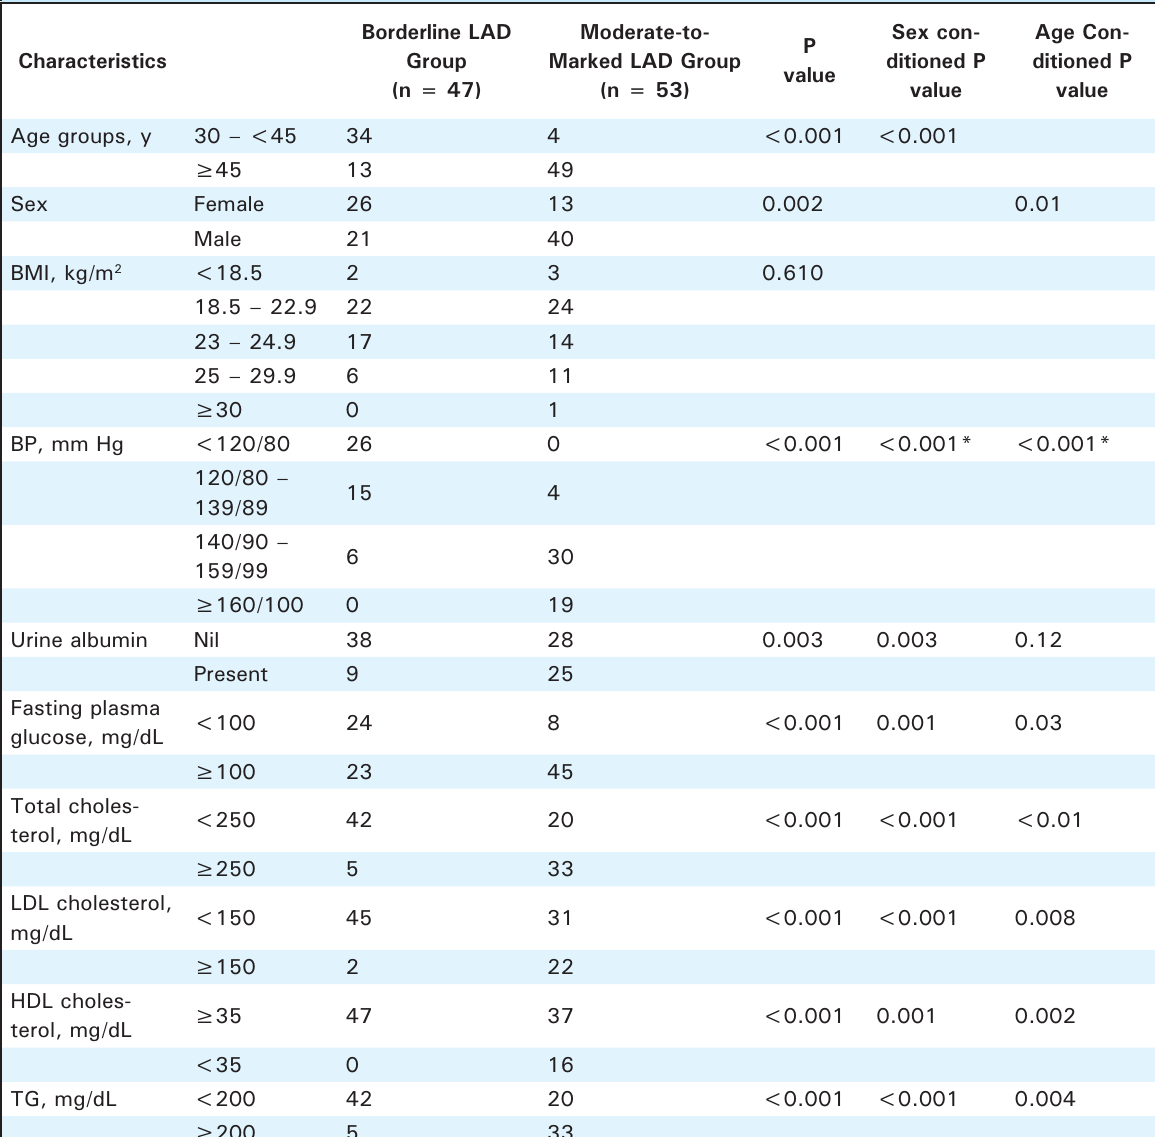
Table 1. Differences in the frequencies of the characteristics of the participants in the two LAD groups.